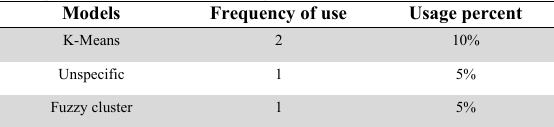
Comparison of the clustering methods